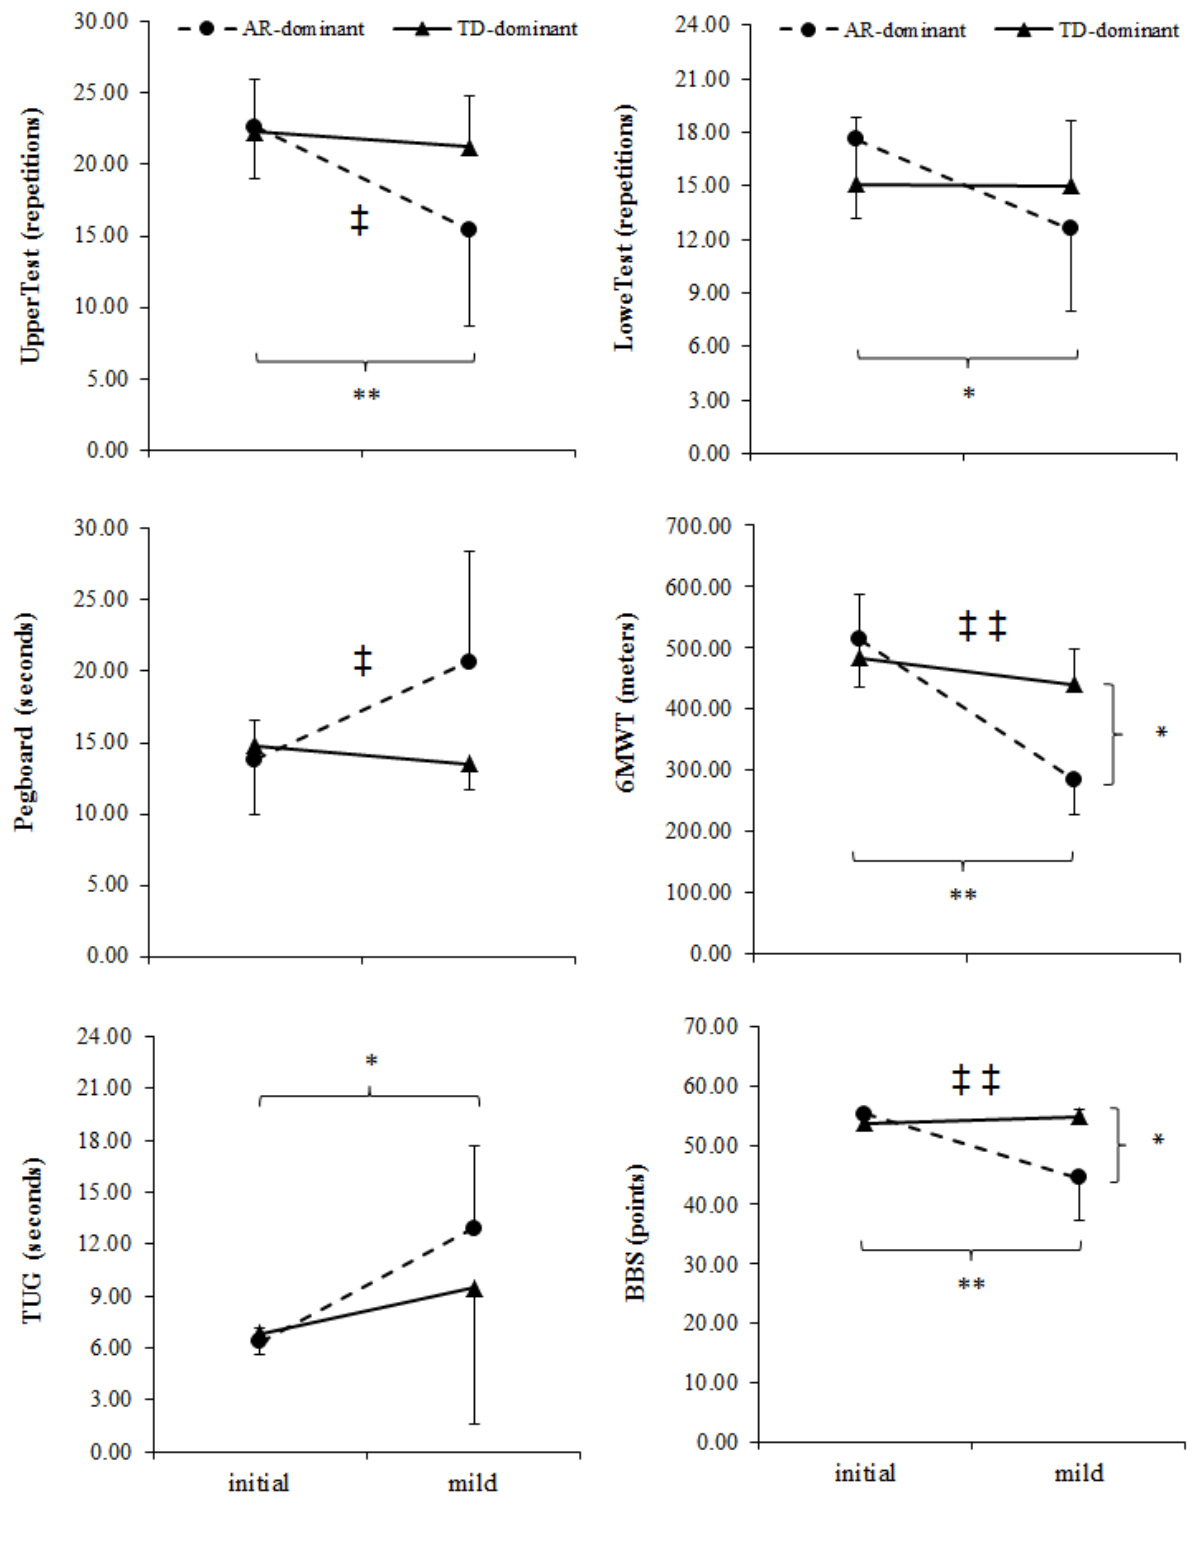
610Figure 1. Performance of all physical capacity